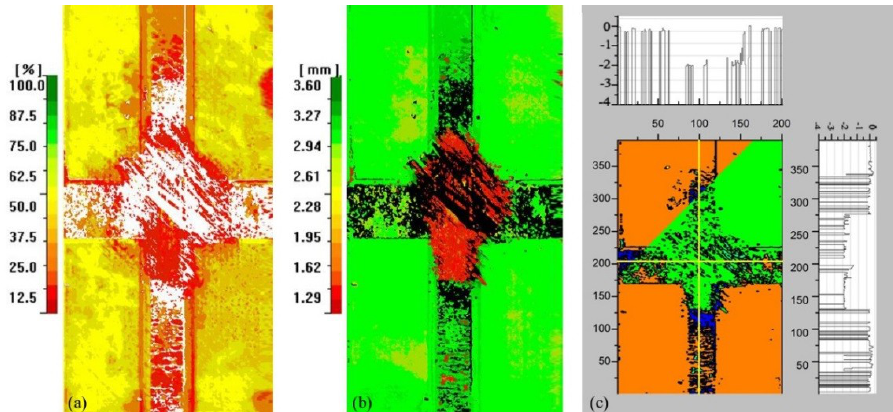
Figure 9. Echo amplitude, echo location, and location data for composite-reinforced panel with a local-sprayed aluminum coating: ( a ) echo amplitude; ( b ) echo location; ( c ) location data (Unit: mm).